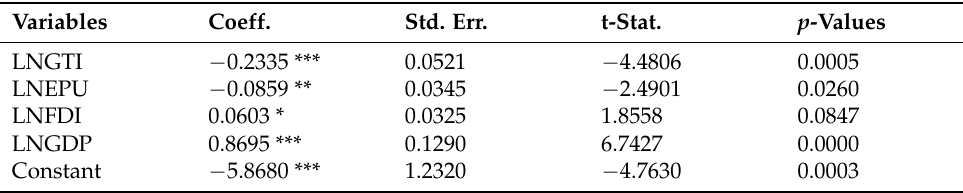
Table 14. Dynamic ordinary least square results.